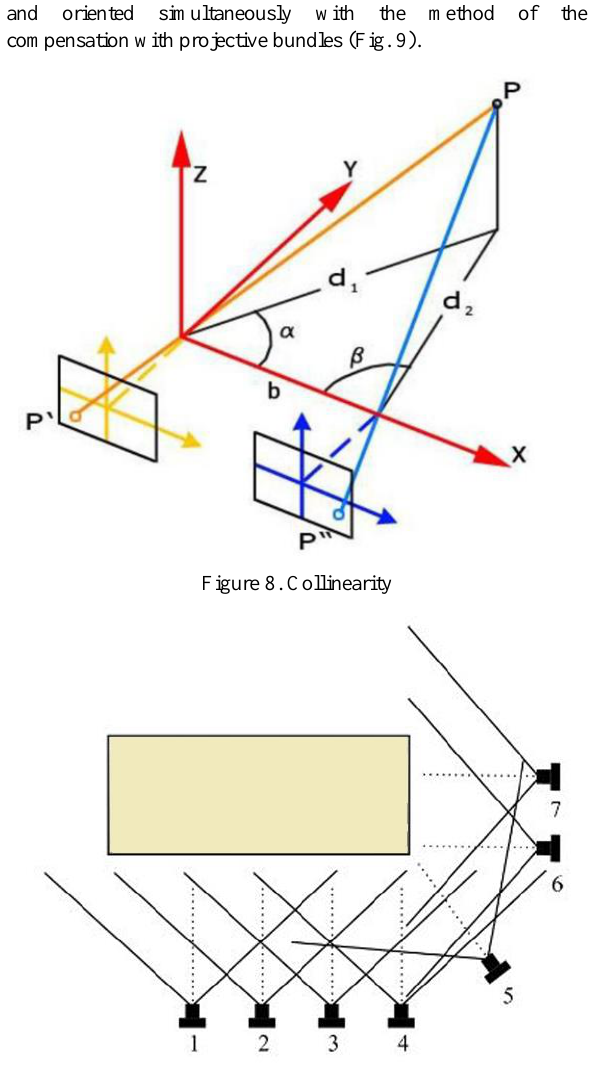
Figure 9. Method of compensating with projective